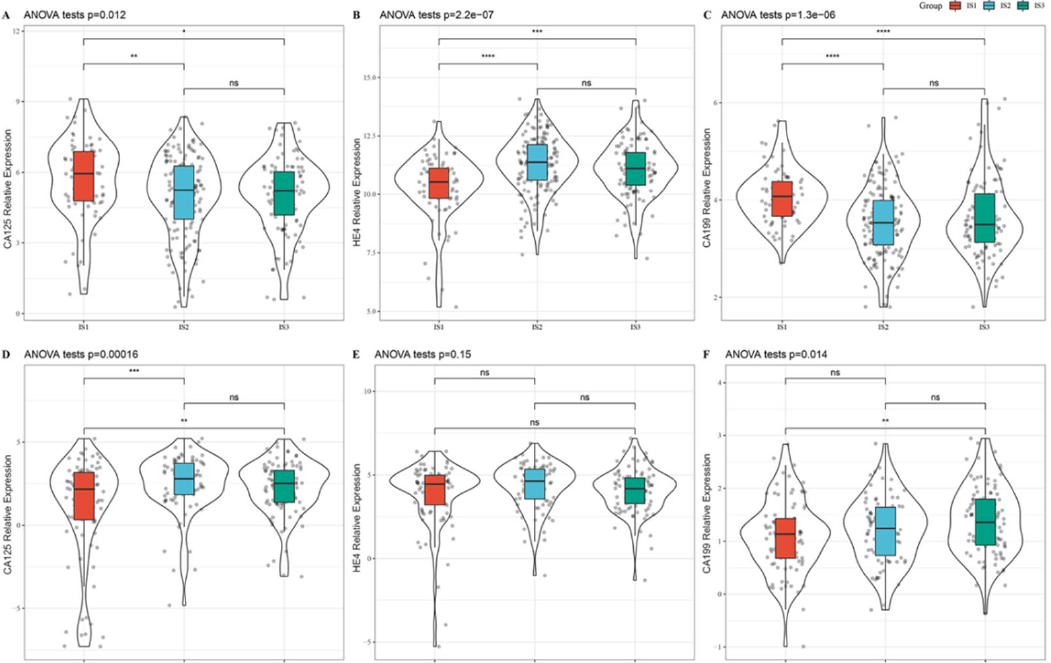
Figure 4. Association between immune subtypes and tumor biomarkers. ( A – C ) CA125 ( A ), HE4 ( B ) and CA199 ( C ) expression among three immune subtypes in the TCGA cohort. ( D – F ) CA125 ( D ), HE4 ( E ) and CA199 ( F ) expression among three immune subtypes in the GSE32062 cohort. * p < 0.05; ** p < 0.01; *** p < 0.001; **** p < 0.0001, and ns, no significance.